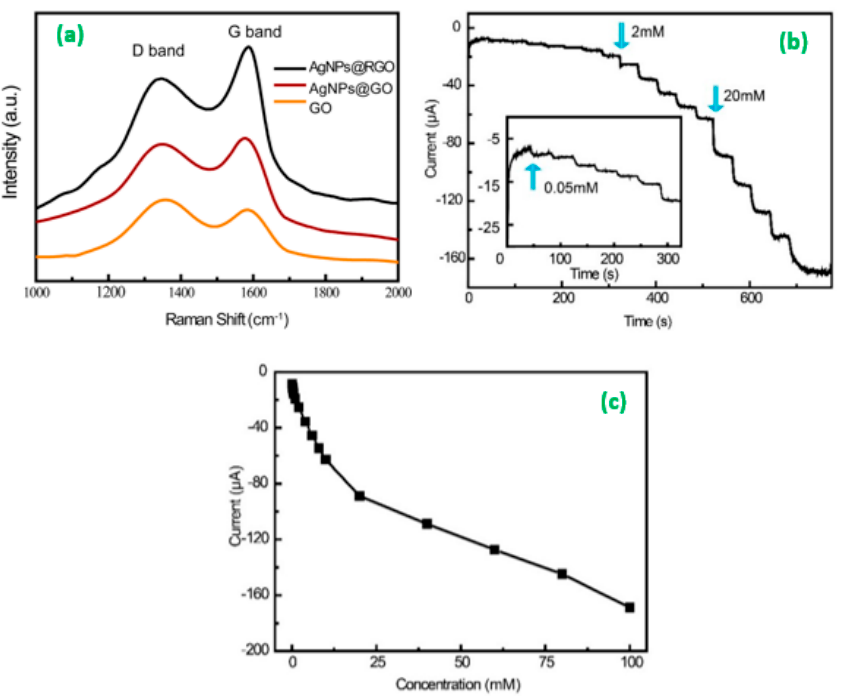
Figure 5. ( a ) Raman spectra of GO, AgNPs@GO. ( b ) Time–current response of the AgNPs@RGO/ITO electrode with a successive injection of H 2 O 2 at the applied potential of − 0.1 V. ( c ) The corresponding calibration plot for H 2 O 2 detection. Reproduced from Zhu, L.; Gao, Y.Y.; Han, B.; Liu, S.; Fu, X.Y.; Dong, H. and Zhang, Y.L., 2019. Programmable laser patterning of Ag nanoparticles and reduced graphene oxide hybrid electrode for non enzymatic hydrogen peroxide detection, ACS App.